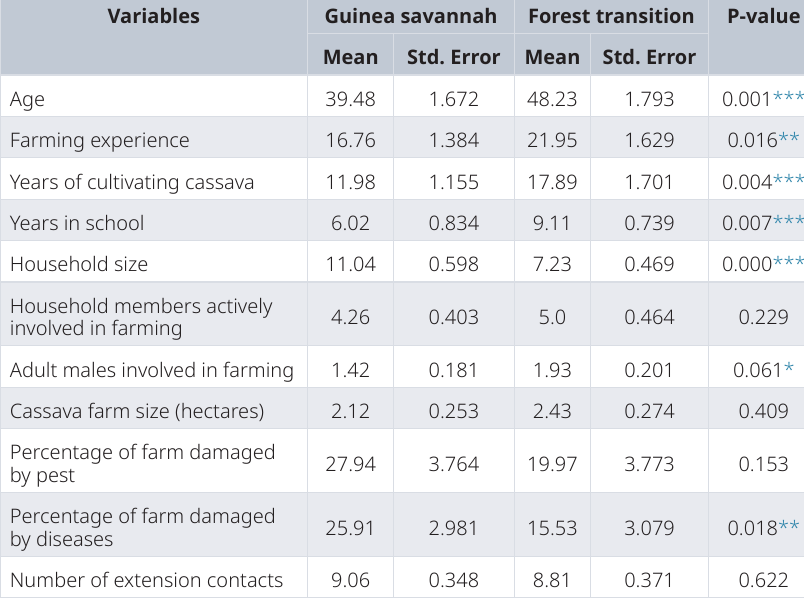
Table 2. Independent sample t-test results (continuous variables).